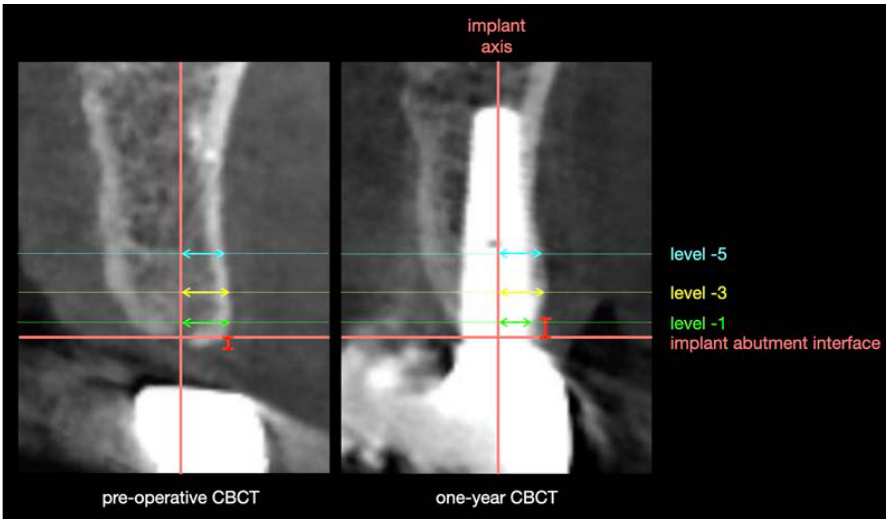
Figure 2. The following reference lines were constructed on the one - year CBCT in the center of the implant: the long axis of the implant, the level of the implant - abutment interface perpendicular to the long axis of the implant, level −1 mm, level −3 mm and level −5 mm apical to the implant - abut- ment interface and perpendicular to the long axis of the implant. Horizontal measurements were performed between the center of the implant and the buccal bone surface at the different levels (level −1 mm: green arrow, level −3 mm: yellow arrow, level −5 mm: blue arrow). Vertical measurement was performed between the implant - abutment interface and the buccal bone peak, parallel to the long axis of the implant (red arrow). 2.5. Vertical Buccal Bone Loss Vertical buccal bone loss was measured on superimposed CBCTs in the same soft- ware (Invivo6, Osteoid Inc., Santa Clara, CA, USA). Figure 2 shows the measurement pro- tocol. First, the one - year vertical buccal bone level was measured between the implant - abutment interface and the buccal bone peak, parallel to the long axis of the implant. A negative value corresponded to a coronal position of the bone peak to the implant - abut- ment interface. Then, the software was changed to the superimposed pre - operative image so that the pre - operative vertical buccal bone level could be assessed while all reference lines remained. Finally, vertical buccal bone loss was calculated by subtracting the one - year vertical buccal bone level from the pre - operative vertical buccal bone level. 2.6. Statistical An alysis A sample size calculation was based on the primary study outcome (change in buccal soft tissue profile) and resulted in the inclusion of 30 patients per group (for details see Cosyn et al. [12]). SPSS Statistics 27 (SPSS Inc., Chicago, IL, USA) was used for data analysis. Five pa- tients were randomly selected for duplicate bone measurements by another clinician. In- ter - assessor reliability was assessed using intra - class correlation coefficient (ICC). Hori- zontal buccal bone loss at the different levels and vertical buccal bone loss were expressed as mean values, standard deviations and 95% confidence intervals. The paired samples t - test was applied to evaluate whether significant bone loss had occurred between the pre - operative situation and the one - year follow - up within each group. Bone loss at the one - year follow - up was compared between the groups using the independent samples t - test. The level of significance was set at 0.05.